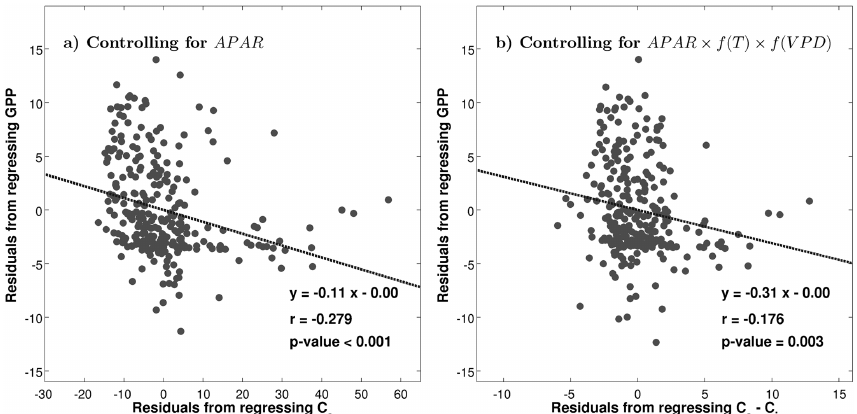
Figure 13. Residual plots are shown for (a) the partial correction between GPP and ambient CO 2 concentration (C a ) while controlling for the variable of APAR and (b) the partial correction between GPP and C a − C i while controlling for the variable of APAR × f (T ) × f